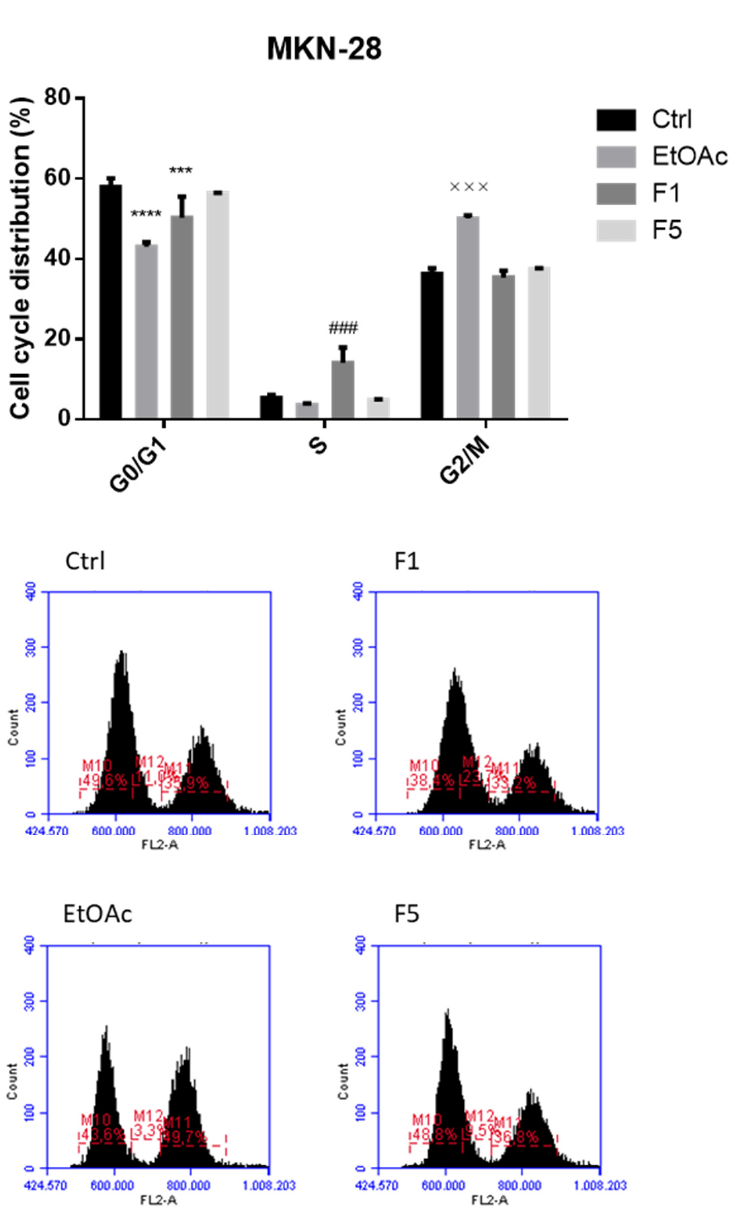
Figure 3. Effect of F. vesiculosus samples on the cell cycle distribution of MKN-28 cells after 48 h. Data are expressed as percentage of propidium iodide positive (PI + ) cells and are presented as the mean ± SEM of at least three independent experiments (*** p < 0.001, **** p < 0.0001 when compared with control; the symbols *, #, and × were used to express statistical significance within G0/G1, S, and G2/M, respectively).